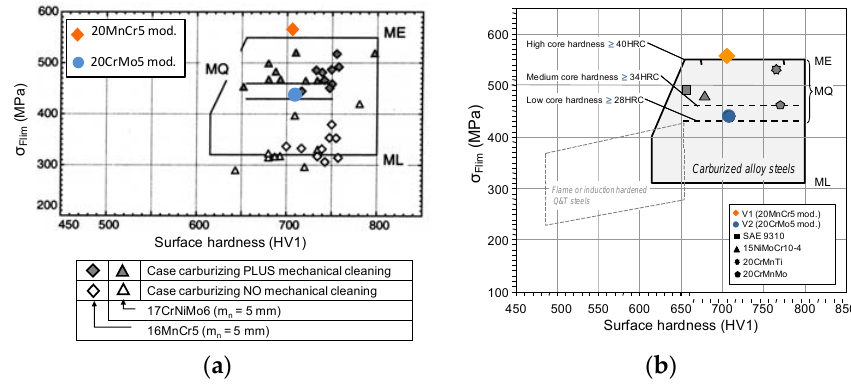
Table 5. Characteristics of the determined S ‐ N ‐ curves concerning tooth root bending strength for 50% failure probability, as well as nominal and allowable bending stress numbers.